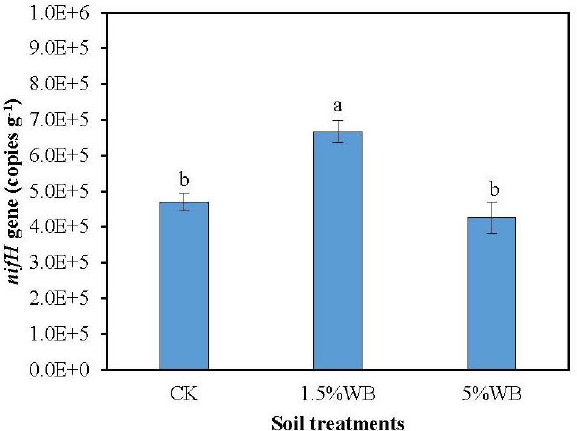
Figure 5. Effect of WB on nifH gene abundance in the coastal soil. CK: soil treatment without WB amendment; 1.5% WB and 5% WB: soil amended with WB at the rate of 1.5% and 5.0% ( w / w ). Different small letters on the bars indicated significant difference between different treatments (Tukey’s HSD test, n = 3, p < 0.05).